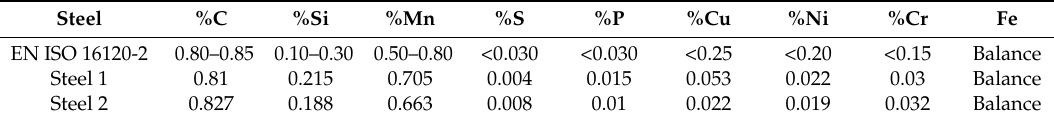
Table 1. Chemical composition (wt. %) of steel batches: Steel 1 (failed) and Steel 2 (good). Steel